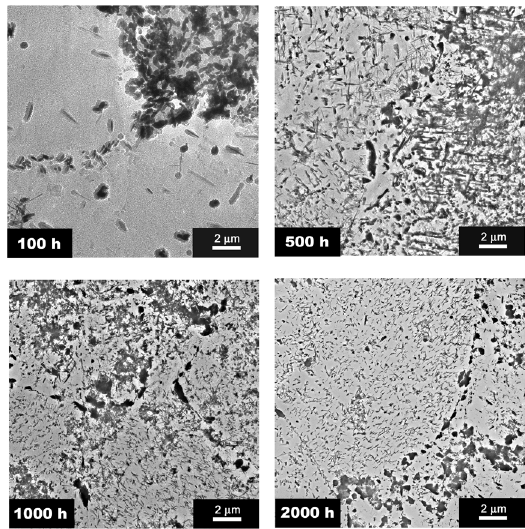
Figure 6: Ferritic-pearlitic steel transmission electron micrographs at 600°C and 100, 500, 1000 and 2000 h of aging.